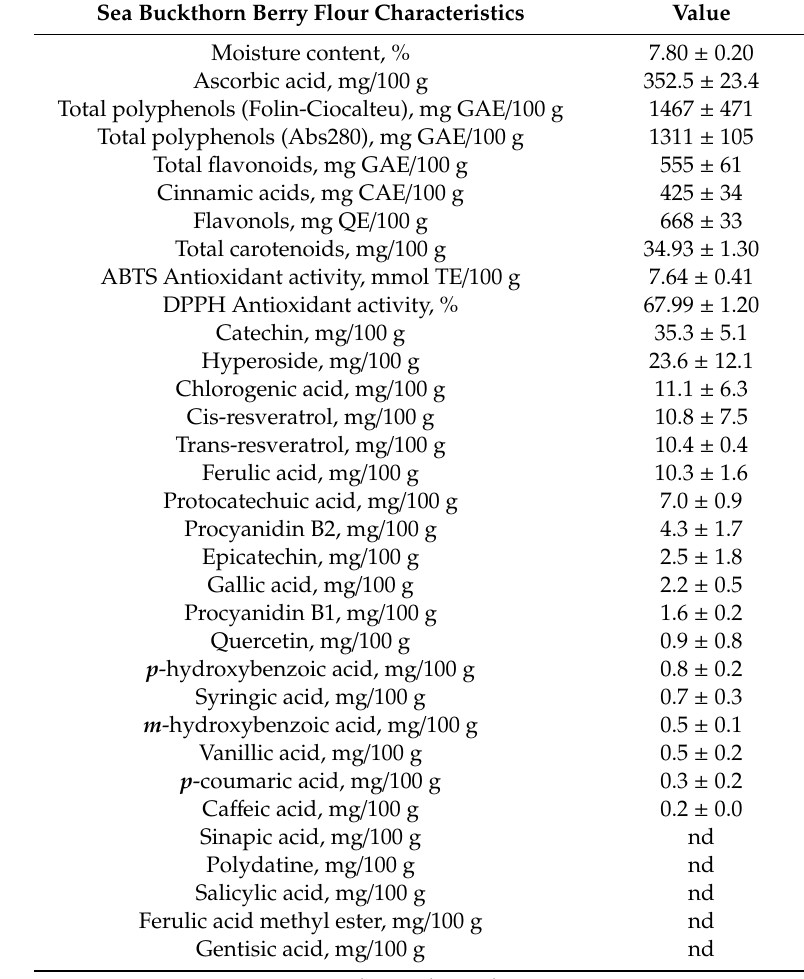
Table 2. General characteristics of the sea buckthorn berry flour used for experiments (the results are expressed as means ± standard deviations of three